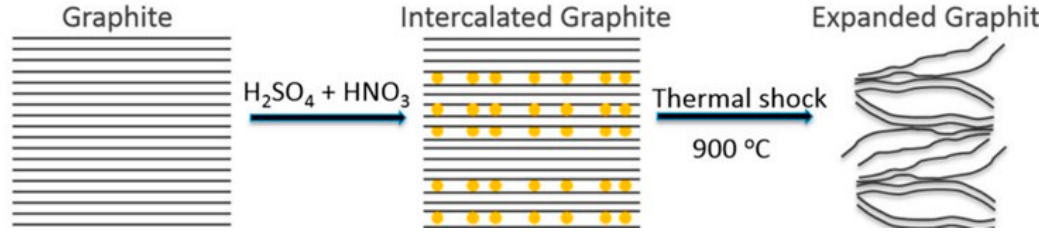
Figure 3. Schematic of expandable graphite (EG) expansion [31].